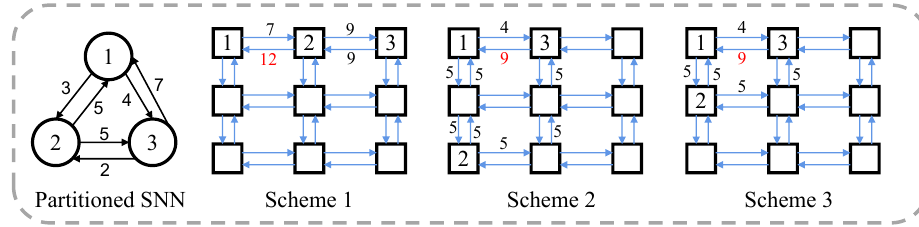
Figure 8. The link workload differences caused by different mapping